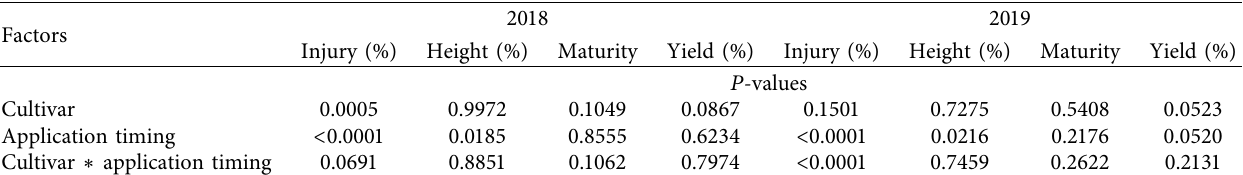
Table 2: Effects of cultivar and application timing for injury, relative height, relative maturity, and relative yield (relative to nontreated) of soybean in at Fayetteville, AR, in 2018 and 2019.